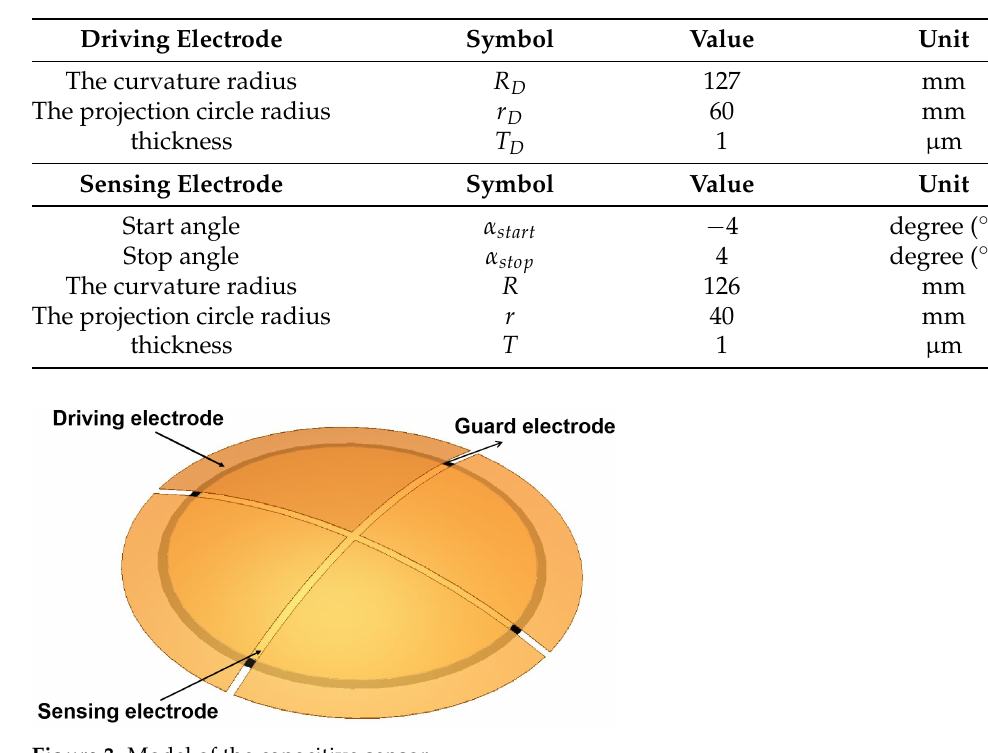
Table 1. Simulation model parameters of the capacitive sensor.